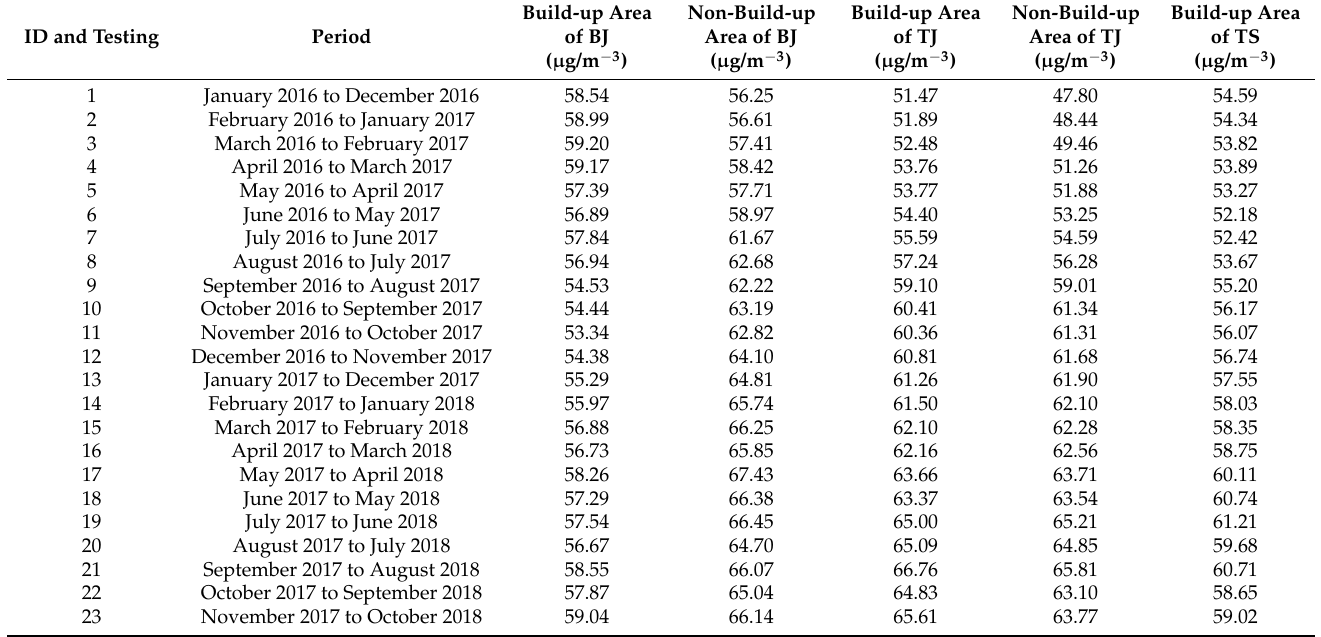
Figure 3. Monthly dynamics of maximum daily 8 h-averaged ozone concentrations (MDA8) in different seasons ( a ) and seasonal difference testing among subareas ( b ). * Significant difference ( p < 0.01) — No significant difference ( p > 0.1). Table 2. Trends of surface ozone concentration over Beijing, Tianjin, and Tangshan from 2016 to 2019 based on a 12-month moving-average time